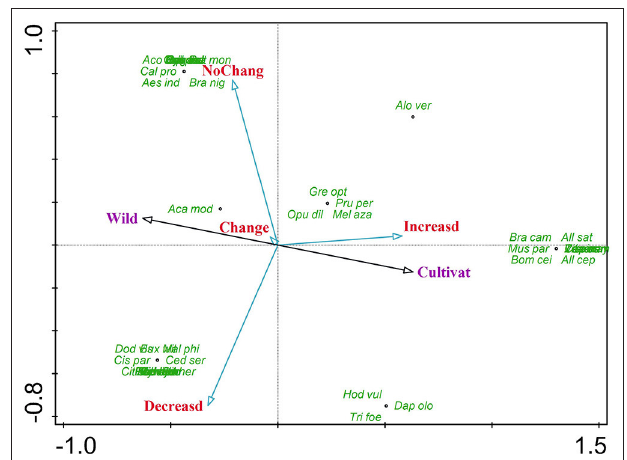
FIGURE 1 | Principle component analysis showing the correlation between plant species and their variables.